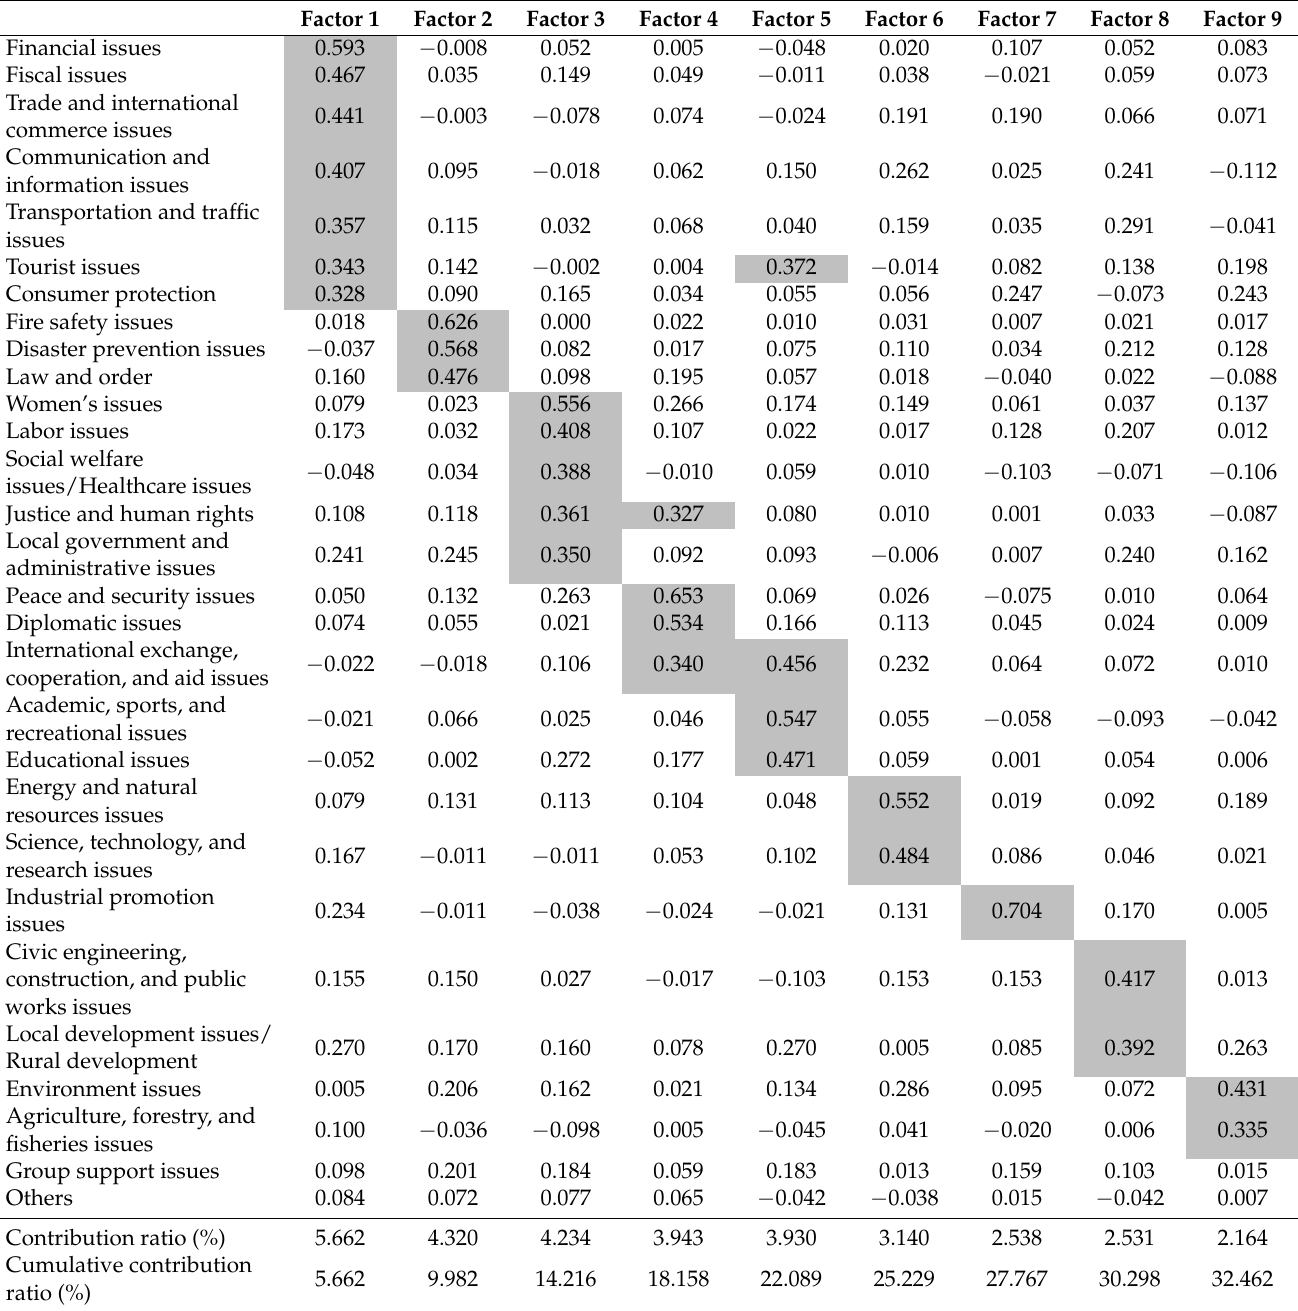
Table 3. Factor analysis of organizations’